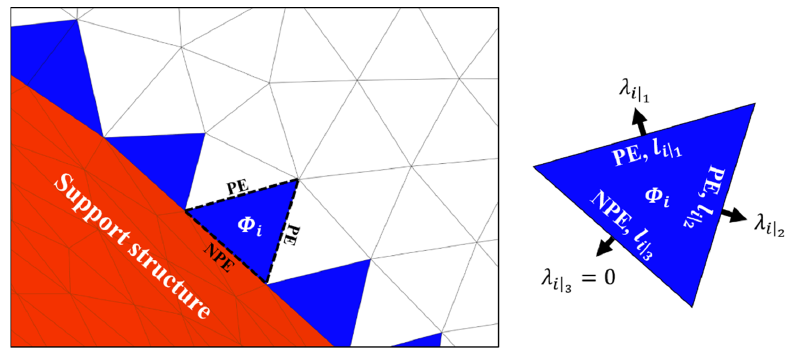
Figure 10. First step of the propagation process for the proposed algorithm.